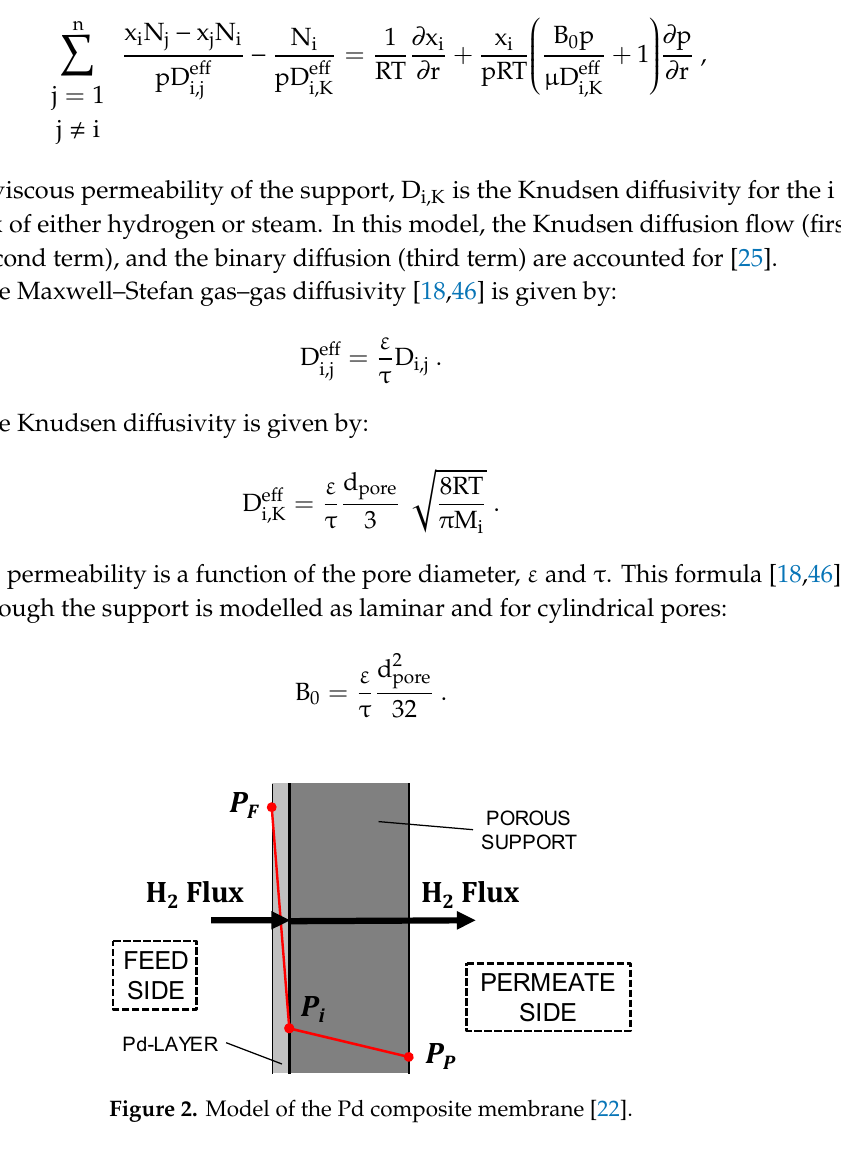
Table 4. Feed stream and reactor conditions, membrane properties [16,27,32] .